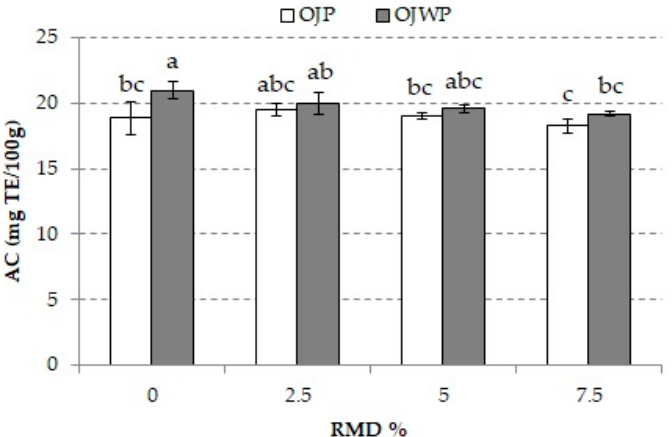
Figure 7. Mean values and standard deviation of antioxidant capacity (AC) of pasteurized orange juice (OJP and OJWP) with 0, 2.5, 5, and 7.5 RMD% after gastrointestinal digestion. Letters indicate homogeneous groups established by the ANOVA ( p < 0.05) for each parameter analyzed. OJP, orange juice with pulp; OJWP, orange juice without pulp.